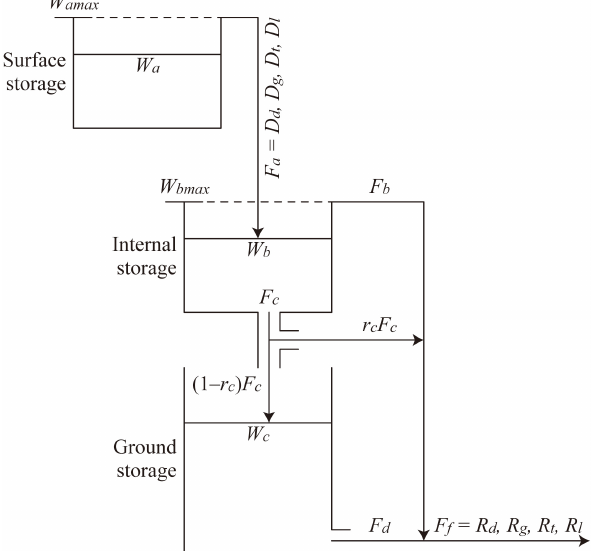
Figure 3. Schematic diagram of the bucket model used in this study (modified after Motoya and Kondo, 1999). Surface storage is used to calculate energy and water balance of the ice-free terrain (see the Sect. 2.3.3). Internal and ground storages are used to calculate final daily runoffs for the individual components such as the debris- covered surface ( R d ) , the debris-free glacier ( R g ) , the ice-free ter- rain ( R t ) , and the lake ( R l )